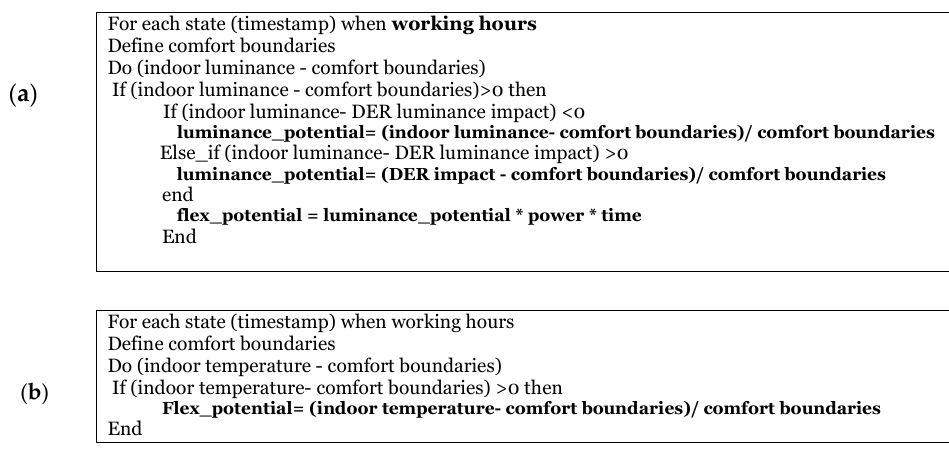
Figure A1. Comfort flexibility calculation: ( a ) Visual comfort and ( b ) thermal Figure 1. Comfort flexibility calculation: ( a ) Visual comfort and ( b ) thermal comfort.